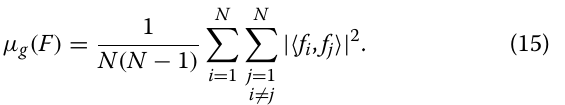
Algorithm 4 may produce nearly equiangular